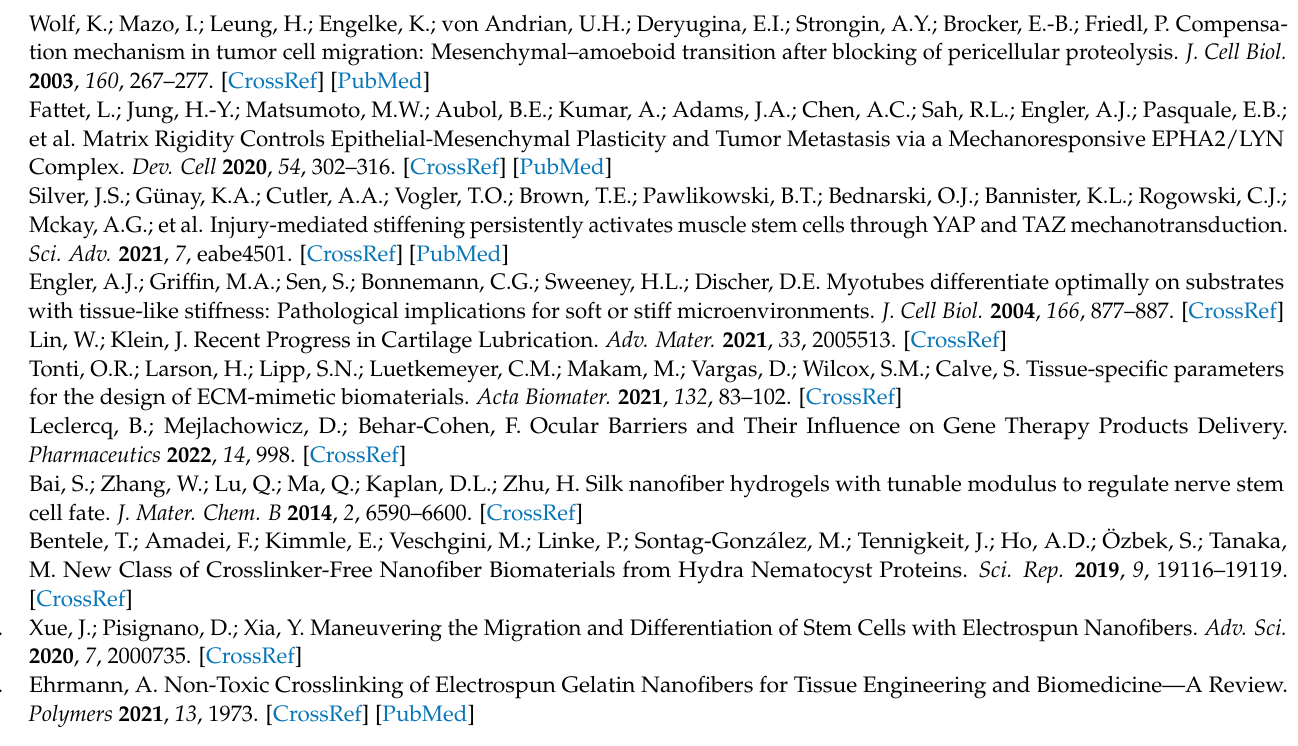
mers. Figure S1: 1 H- 1 H 2D rotating-frame nuclear Overhauser effect spectroscopy (ROESY) NMR spectrum of amino- β CD/amino-Ad complex in D 2 O. Figure S2: ATR-FTIR of materials related to gelatin- β CD-Ad (Method 1). Figure S3: ATR-FTIR of materials related to gelatin- β CD-gelatin and Ad-gelatin (Method 2). Figure S4: Optical microscopy images of β CD-gelatin/Ad-gelatin nanofibers (Method